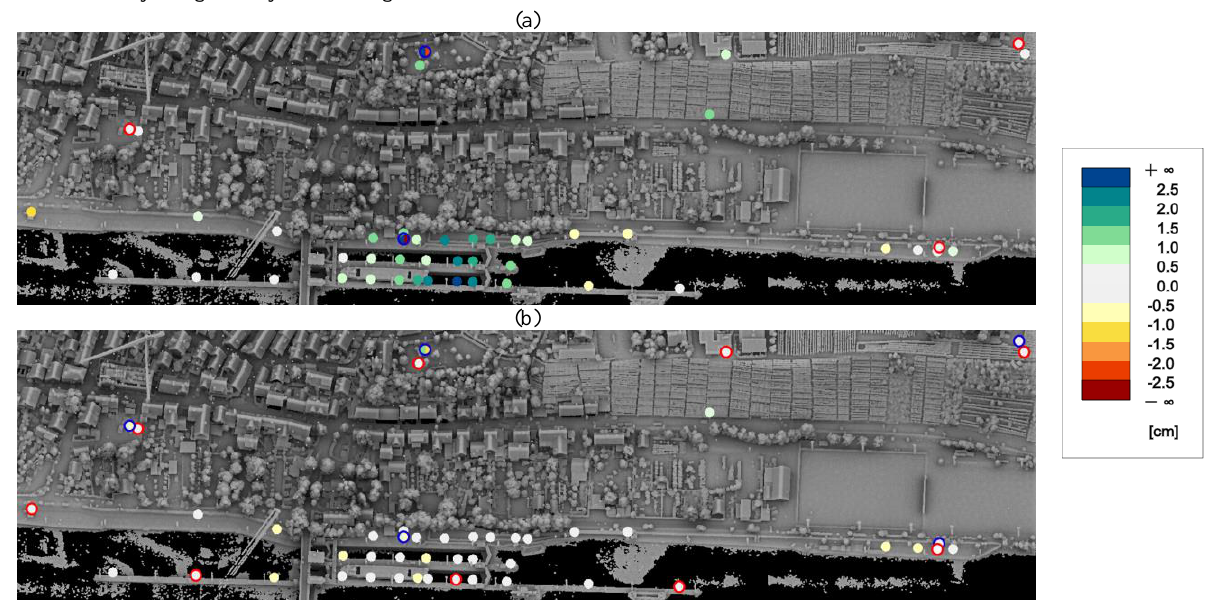
Figure 5. Point-to-plane distances of LiDAR point cloud to signalized targets. Top : Results from LiDAR strip adjustment, Bottom : Results from hybrid orientation. Control information in terms of LCPs ( top ) and PCP ( bottom) is highlighted by red circles. LCPs used as check points are indicated by blue circles and denote differences to both roof planes